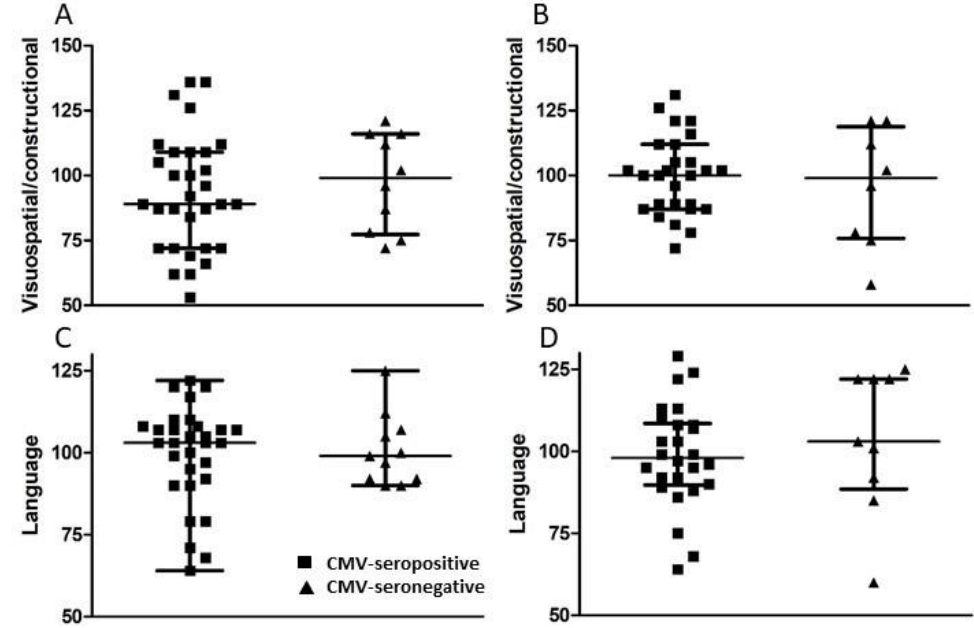
Figure 6. Comparison of visuospatial/constructional and language scores between groups of CMV-seropositive and -seronegative subjects at t1 and t2. ( A , C ) Following neuropsychological testing, visuospatial/constructional and language scores were calculated at t1 for all study subjects and ( B , D ) approximately 18 months later (t2) for all study subjects completing follow-up. Error bars on graphs show median ± interquartile range for each group. No significant differences between CMV-seropositive and -seronegative groups were observed. Mann–Whitney U -test, ( A ) p = 0.429, ( B ) p = 0.708, ( C ) p = 0.701, ( D ) p =